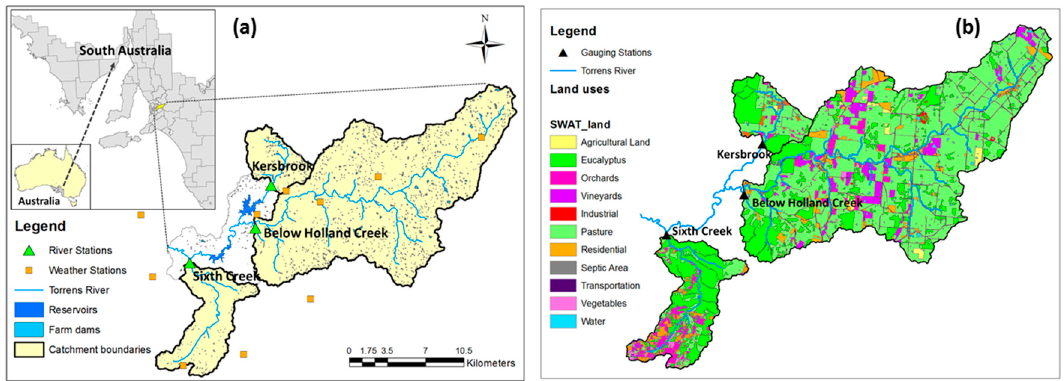
Figure 1. The study area: ( a ) Locations of gauging stations; ( b ) Land uses map.